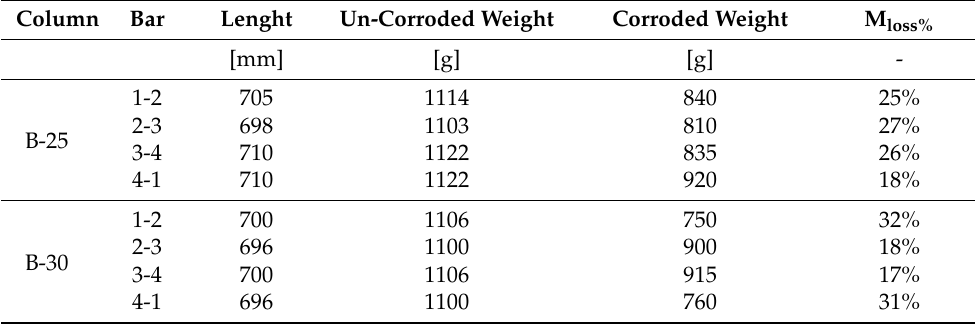
Table 3. Weight and loss mass value of the corroded steel rebars.